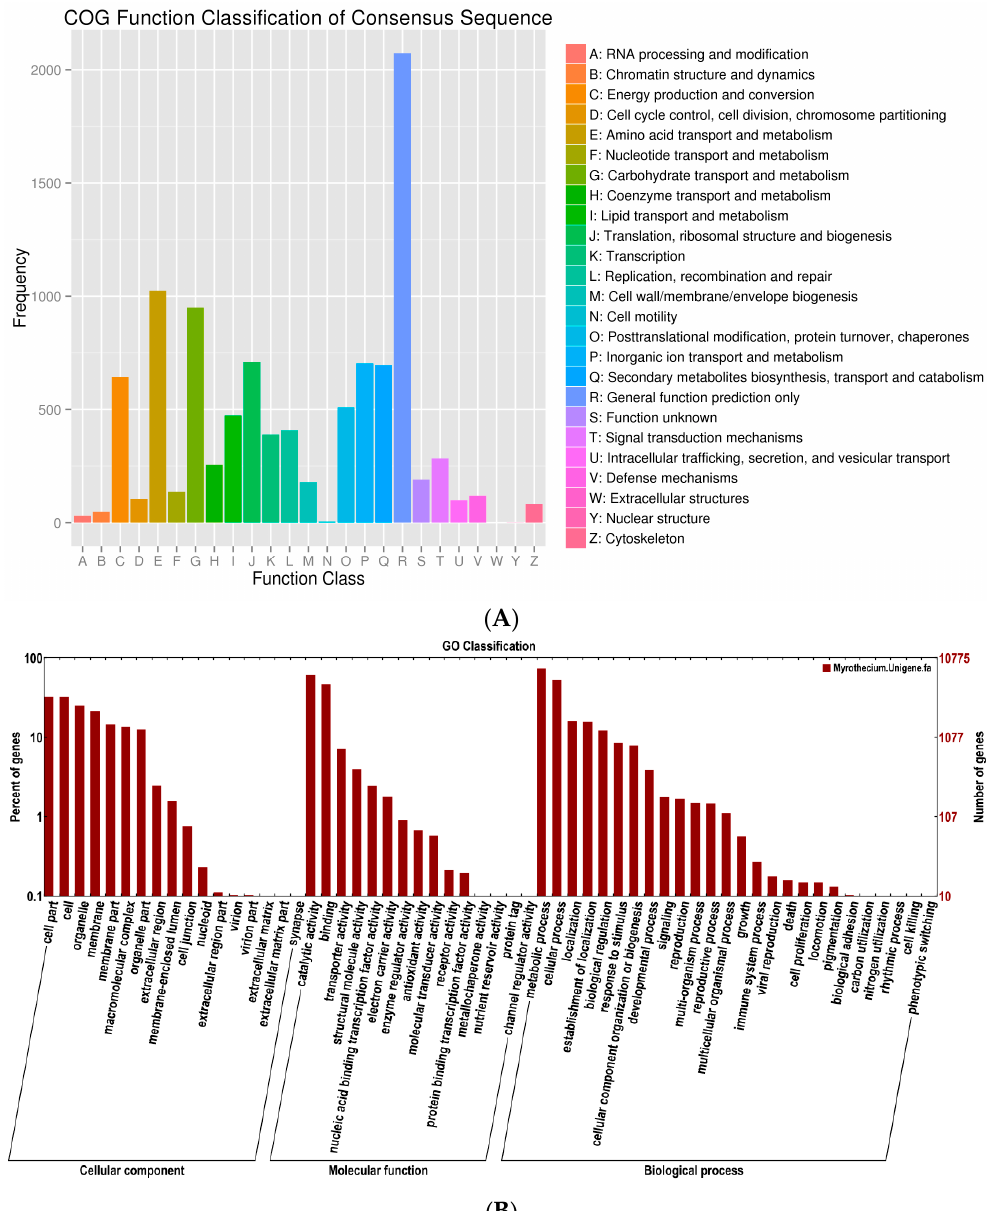
Figure 2. COG function and GO function classification of the M. roridum transcriptome. ( A ) COG functional classification of the M. roridum transcriptome; ( B ) GO functional classification of the M. roridum transcriptome.